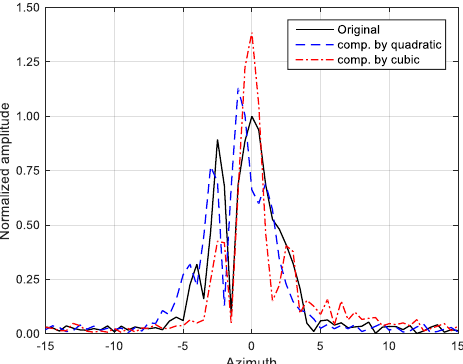
Figure 8. Comparison of residual azimuth compression for vehicle 2: signals of original SLC (black solid line); result of the residual compression achieved by an optimal quadratic phase model (blue dashed line); result of residual compression after applying a cubic-phase model (red dot-dashed line). Note the asymmetric side-lobes after applying the cubic-phase model. Amplitude was normalized by the peak value of the original signal. The entropies of the original model, compressed by quadratic-phase model, and cubic-phase model, were 2.646, 2.627, and 2.148, respectively.